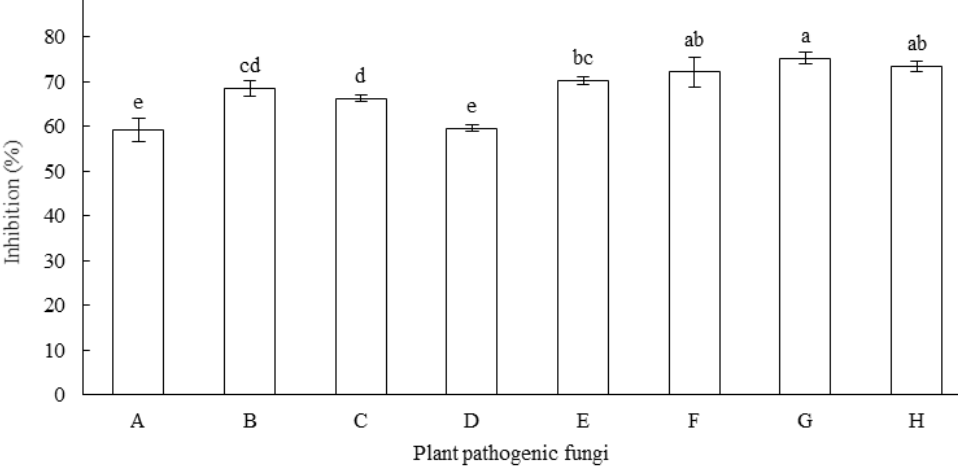
Figure 1. Antagonistic activities of MR-57 isolate against fungal pathogens. Growth inhibition percentage (%) of fungal pathogens based on dual culture assays. A: R. solani , B: P. cactorum , C: B. cinerea , D: F. oxysporum , E: A. tenuissima , F: A. liriodendron , G: C. destructans , H: M. acerina . Vertical bars represent standard deviation of the means ( n = 3). Bars followed by the different letters are significantly different at p < 0.05 according to Duncan’s DMRT. F value showed 34.596, p value showed 0.0001.